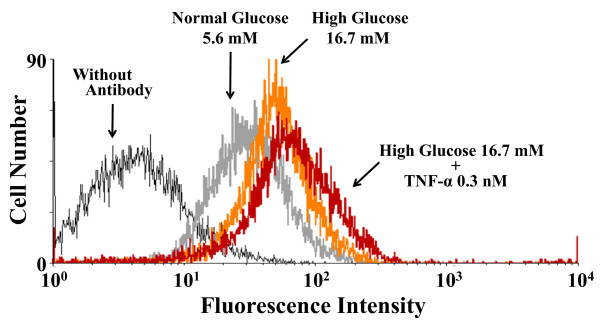
Representative histograms of HCAECs expressing TNF-R1. Surface expression of TNF-R1 was analyzed by flow cytometry using FITC-labeled anti-human TNF-R1 antibody. Cells were treated with 16.7 mM glucose in the presence or absence of 0.3 nM TNF-α for 24 h. Similar results were obtained with two additional experiments.